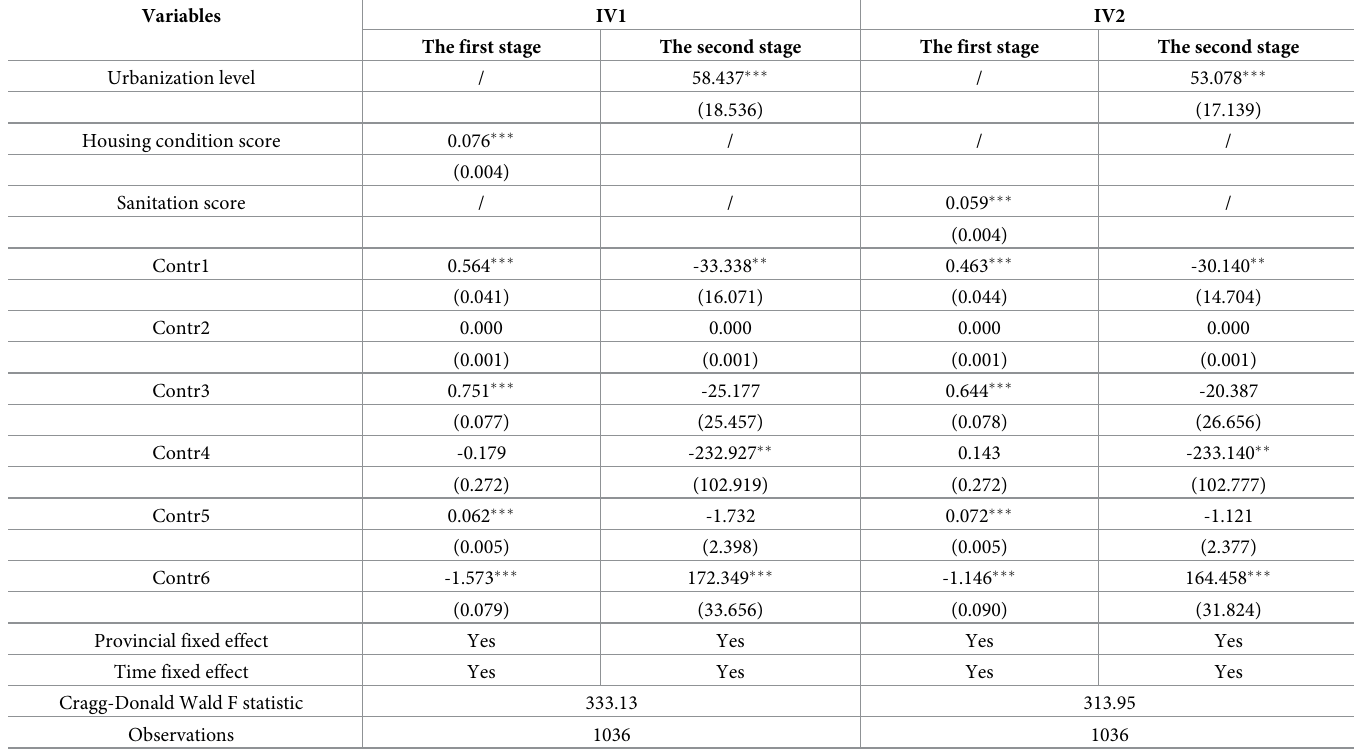
Table 8. The estimation results of Model 1 estimated by IV-2SLS